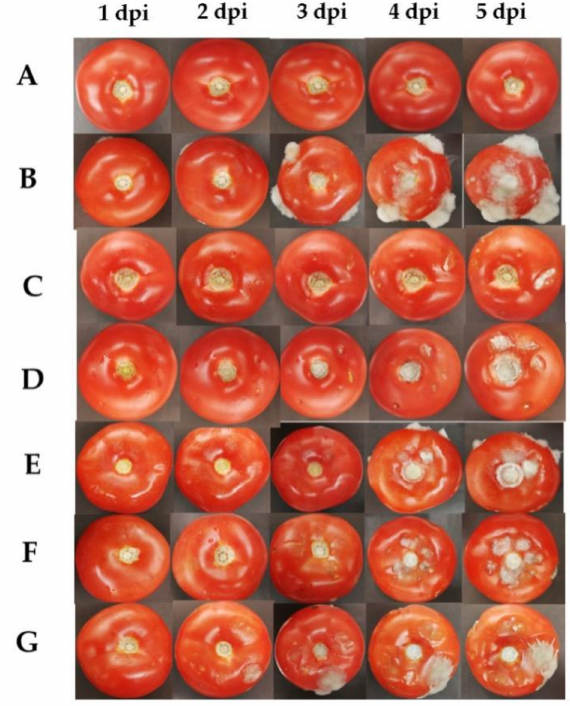
Figure 3. Effects of mixtures of (EO/HYS) and hydrolates (HYSs) of T. vulgaris and O. vulgare at different concentrations for controlling gray mold caused by B. cinerea on tomato fruits for five days post inoculation (dpi): ( A ) Control (-); ( B ) inoculum Control; ( C ) EO/HYS 0.135/30 (% v / v ), thyme; ( D ) HYS 30% v / v , thyme; ( E ) EO/HYS 0.135/30 (% v / v ), oregano; ( F ) HYS 30% v / v , oregano; ( G ) BC-1000 ® 0.135% v / v